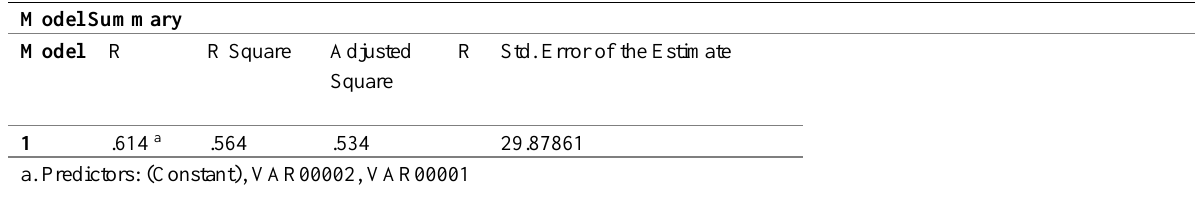
Table 10: Coefficient Determination Score (R 2